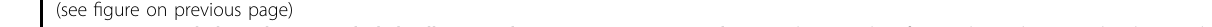
Fig. 3 Macrocephaly and increased glial cells in newborn CHD8 mutant monkeys. a Photographs of control-2 and M2 monkey brains. The brains were sliced at the same position (red lines) for immunostaining. Quanti fi cation of brain weights of M2 and six age-matched controls is shown on the right panel. Scale bar: 1 cm. b GFAP immunostaining of the white matter in control and CHD8 mutant monkeys. The thickness of gray matter, which is GFAP-negative, in the cortical regions of M2 and age-matched control-2 is shown on the right panel ( n = 8 measures in each animal). Scale bar: 1 mm. c GFAP immunostaining of the entire cortical layers of control and CHD8 mutant monkeys. GM gray matter; WM white matter. Scale bar: 50 μ m. d Large magni fi cation micrographs of GFAP immunostaining in the white matter of control and CHD8 mutant monkeys. Scale bar: 20 μ m. e Quanti fi cation of the density of GFAP-positive cells from GFAP-immunostaining results. The data were obtained by counting 4 – 11 images in each group and presented as means ± SEM per mm 2 . * P < 0.05; ** P < 0.01, *** P <